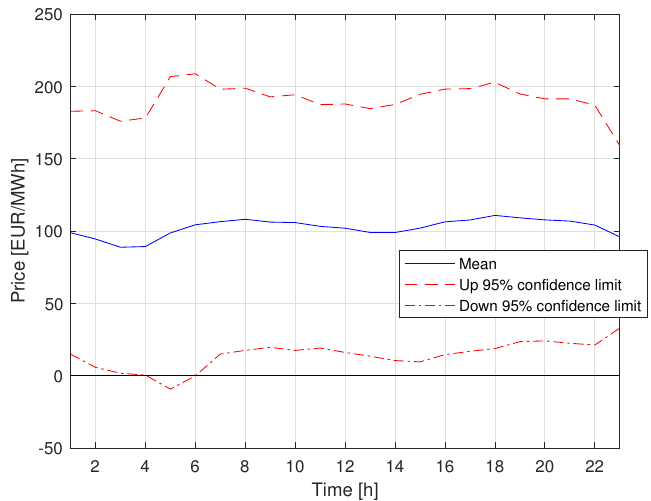
Figure 12. Probabilistic model for price of upward regulation in center north zone.